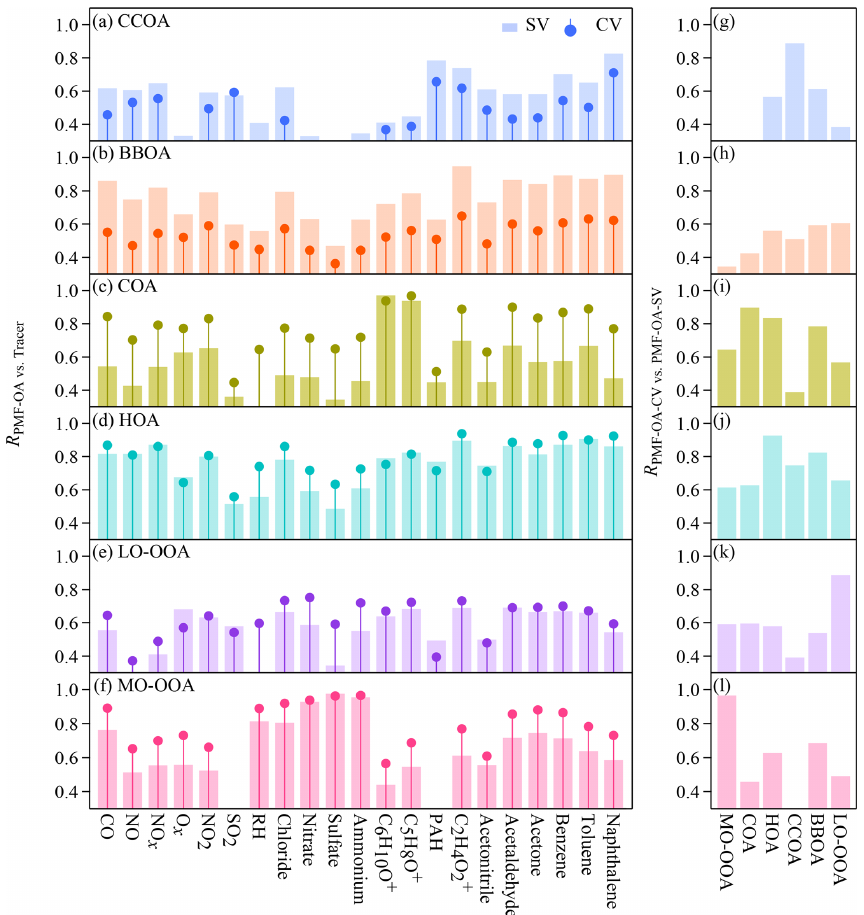
Figure 6. Pearson’s R values for (a–f) the correlations between the time series of the concentrations of the six OA factors that are identified by the PMF analysis on the CV and SV data sets and potential tracers and (g–l) the correlations between the time series of the concentrations of each OA factor from the CV data and the six OA factors from the SV data. PAH refers to the particle-phase PAH concentrations detected by the SV